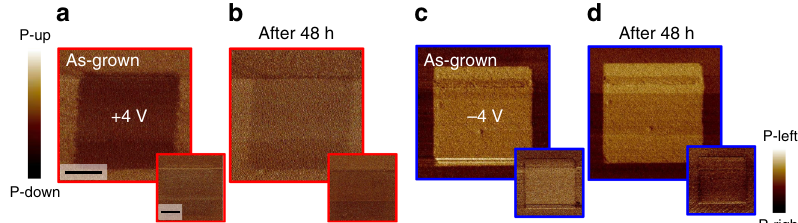
Fig. 4 Stability of the electric- fi eld-induced polarization switch over time. a – d PFM out-of-plane (in-phase, main panel) and in-plane (quadrature, inset) data immediately after the poling (±4 V) and 48 h later for a , b competitive and c , d cooperative interface con fi gurations. PTO fi lms are 20 u. c. thick and scale bars are 1 μ